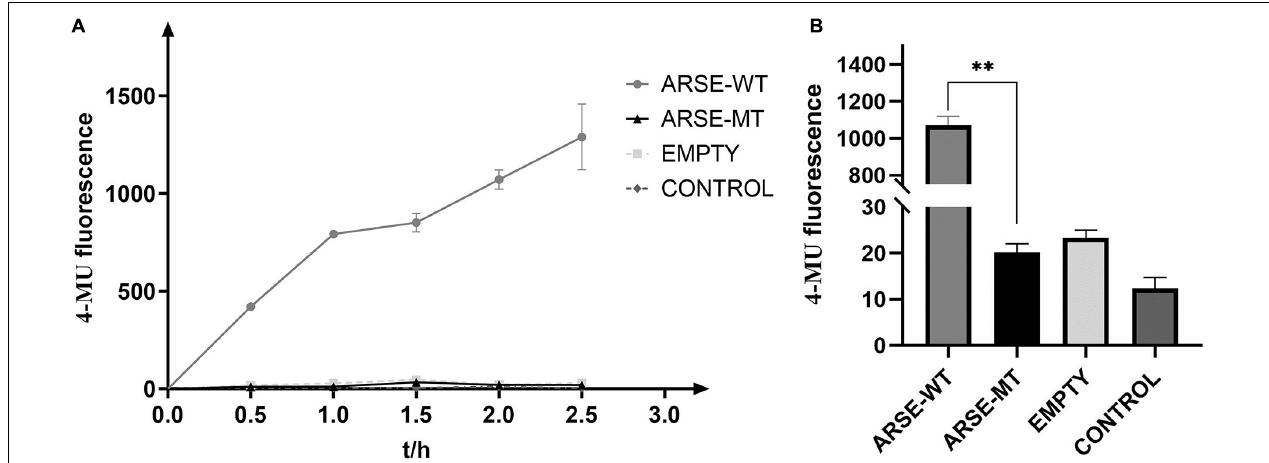
FIGURE 3 | Determination of enzyme reaction of ARSE shows the mutated protein have negligible arylsulfatase E activity. (A) ARSE enzymatic reaction process curve. (B) Comparison diagram of enzyme activity shown at 2 h after ARSE enzymatic reaction. Statistical analysis and mapping were performed by GraphPad Prism. ARSE-WT, wild-type ARSE; ARSE-MT represents the mutated ARSE, EMPTY represents the empty plasmid vector group, and CONTROL represents the blank-control of 293T cells. The difference between ARSE-WT and ARSE-MT is tested by Student’s t -test. ∗∗ p < 0.1.